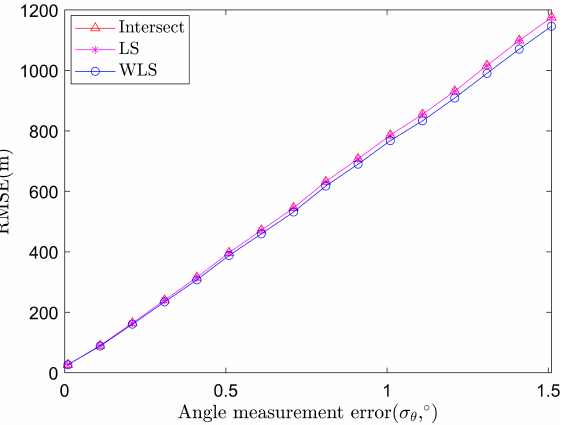
Figure 3. Average RMSE of target localization algorithms based on angle measurements of two sensors at a fixed self-positioning